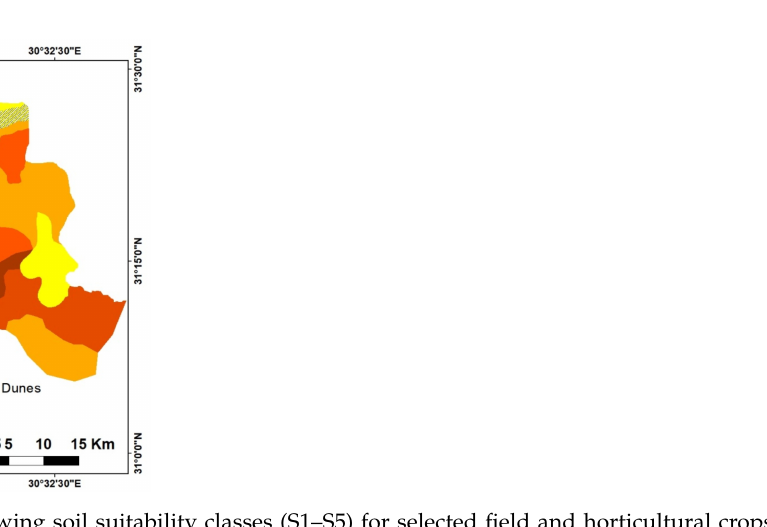
Figure 8. Maps showing soil suitability classes (S1–S5) for selected field and horticultural crops. Lowercase letters represent main soil limiting factors in each class; s, salinity; t, texture; a, sodium saturation; d, drainage; c, carbonate content; p, profile depth.